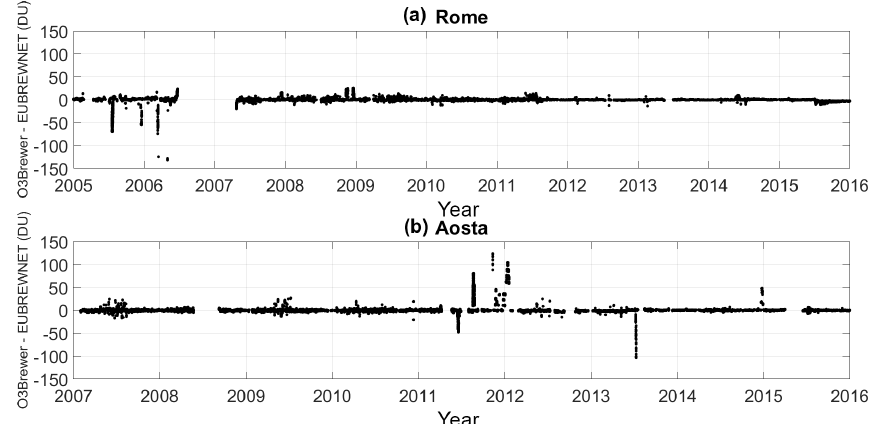
Figure 14. Difference between individual TOC values generated by O3Brewer and EUBREWNET ( a , Rome; b , Aosta). Periods belonging to the three circumstances described in the Sect. 3.1 with the R 6 drift or spikes were removed.